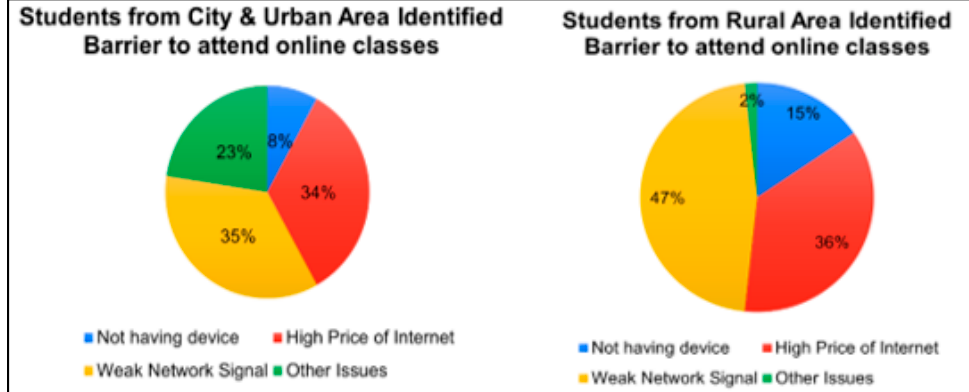
Figure 3. Barriers to joining online classes in different geographic regions.